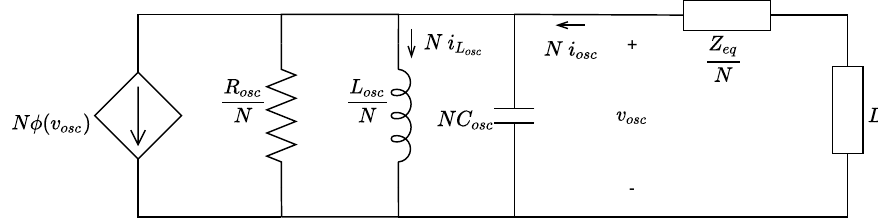
Figure 3. Microgrid schematic representation after synchronization.